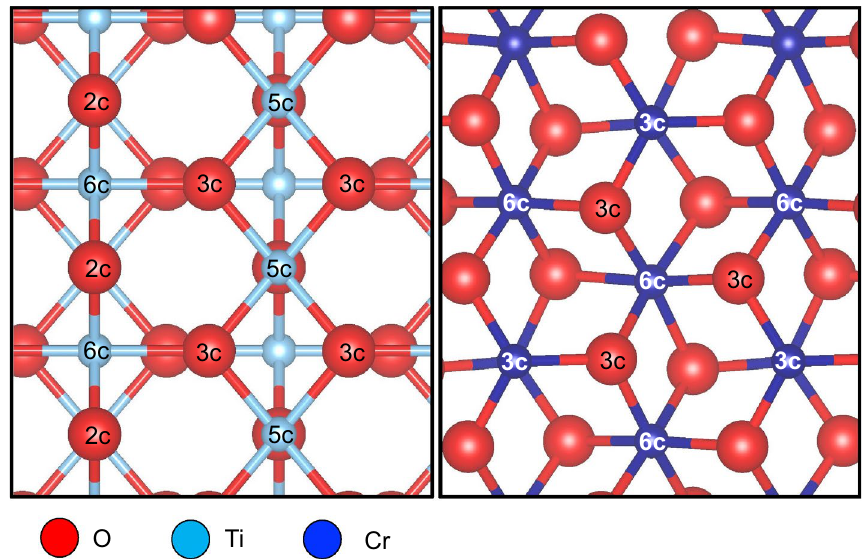
Figure 2. Top view of TiO 2 (110) (left panel) and Cr 2 O 3 (0001) (right panel), with coordination numbers of surface and subsurface atoms indicated. Note the lower coordination number of the surface Cr atoms as compared to the surface Ti atoms.